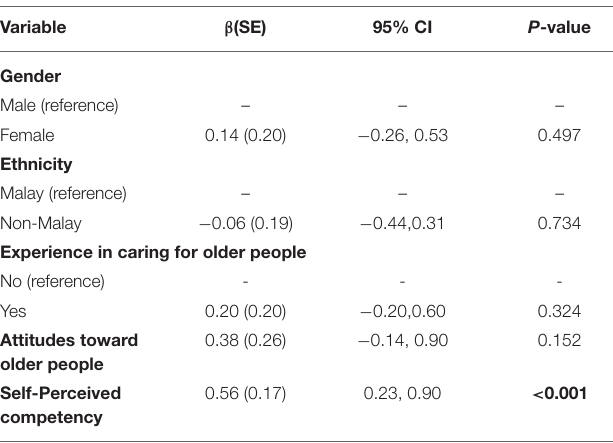
TABLE 3 | Association between Interest in geriatric medicine as a career of choice and study variables (post-course).